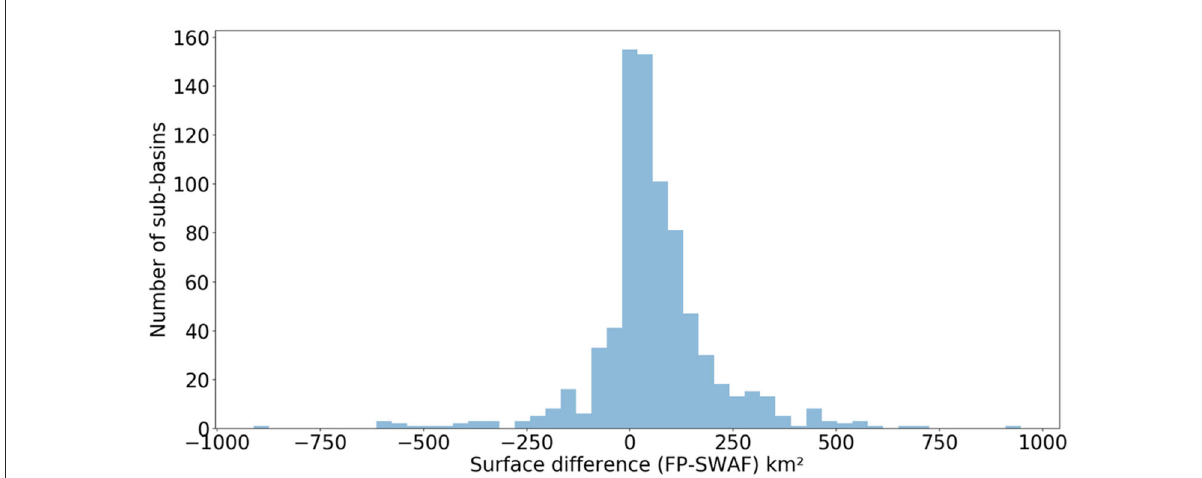
FIGURE5 Distribution of the areas of the estimated floodplains for the SWAF and DEM methods. If the value is positive, then the DEM methodology estimates a larger floodplain than SWAF. Overall both methods return similar floodplain delineations.